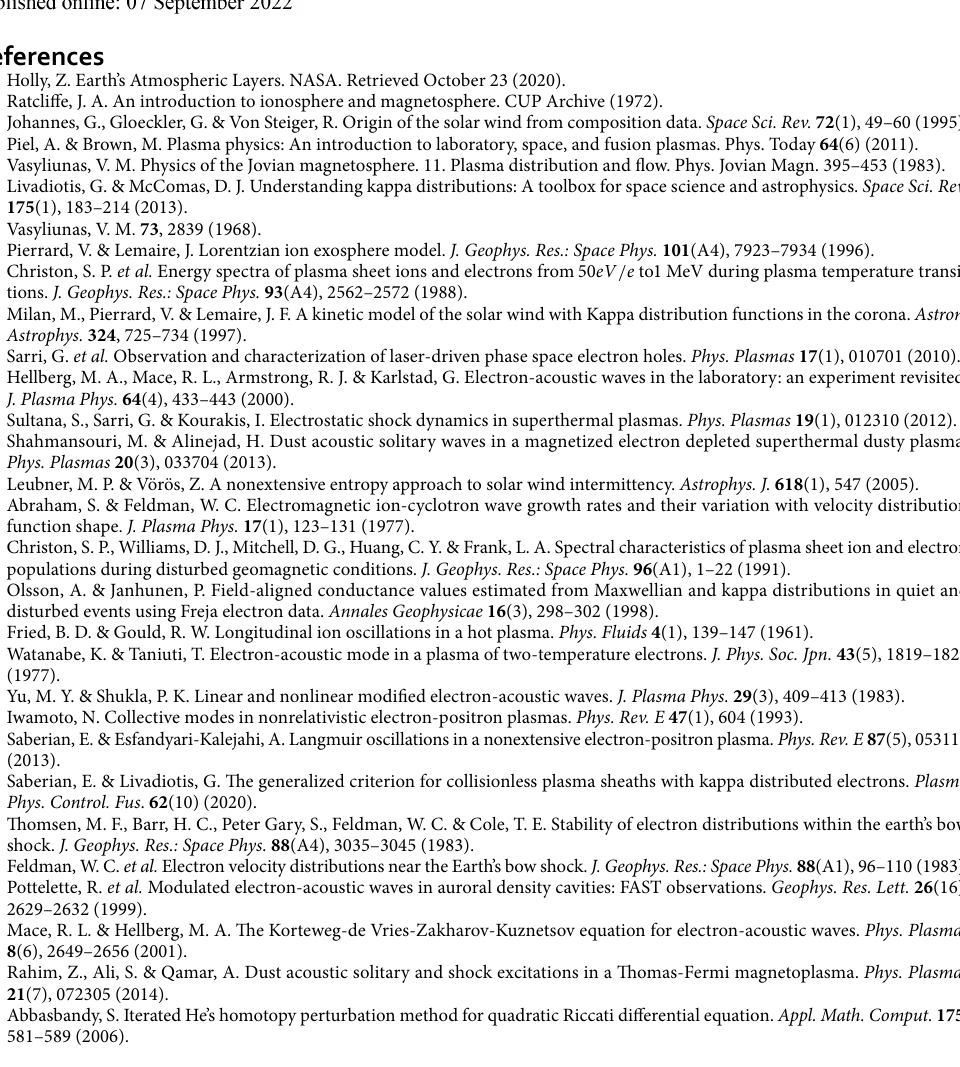
Figure 8. The approximate (MDLDM) solution is plotted for different values of (dashed curve) and